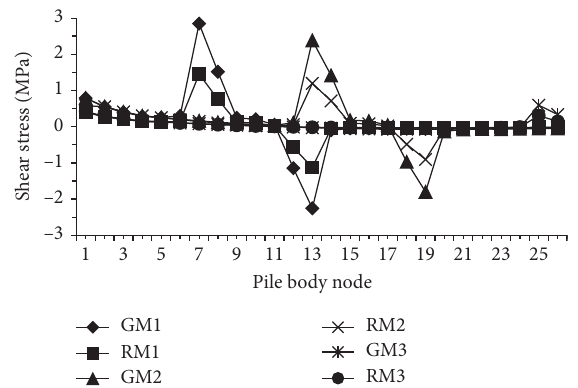
Figure 19: Diagram of shear stress curve of the pile body.